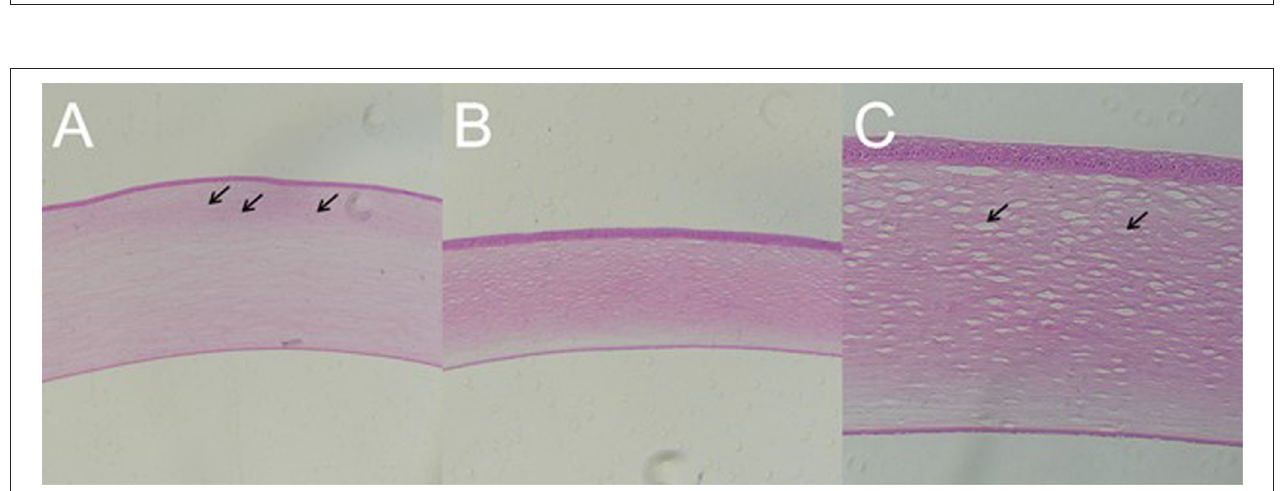
FIGURE 9 | Gross pathology of cornea of animal model with closed globe blast injury at day 7. (A) : Eyes with residual corneal edema: The stroma layer was thickened, where the inflammatory cells infiltrated close to the external elastic layer shown by black arrows ( × 100). (B,C) : Corneal edema occurred immediately after blast and self-healed at day 7: Stromal thickness was normal ( × 100), whereas loosen stroma was left at higher magnification shown by black arrow ( × 200).